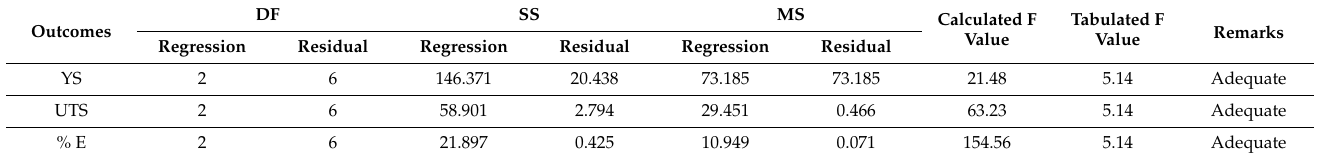
Table 7. Statistical model—ANOVA test results.